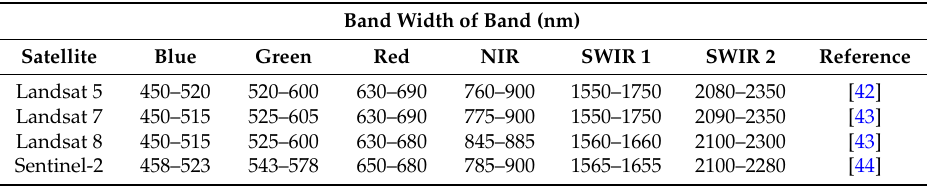
Table 4. Overview of the bandwidth of the satellites Landsat 5, 7, 8, and